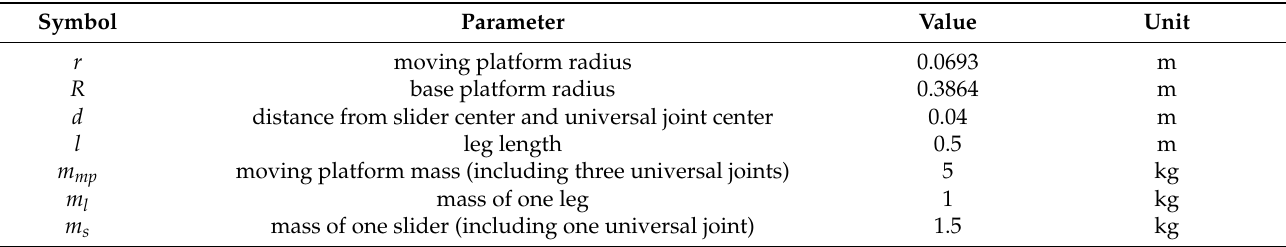
Figure 3. Multibody model of the 3-PUU parallel robot. Table 1. Geometrical and inertial parameters of the 3-PUU parallel